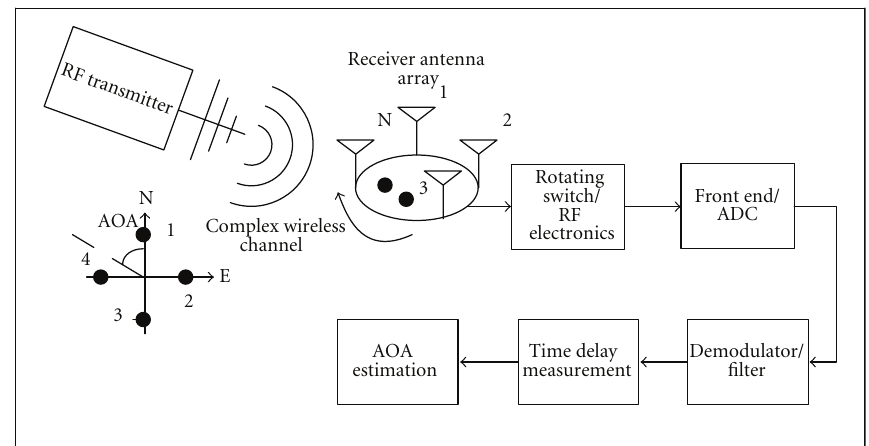
Figure 1: Block diagram of a single channel car localization system.